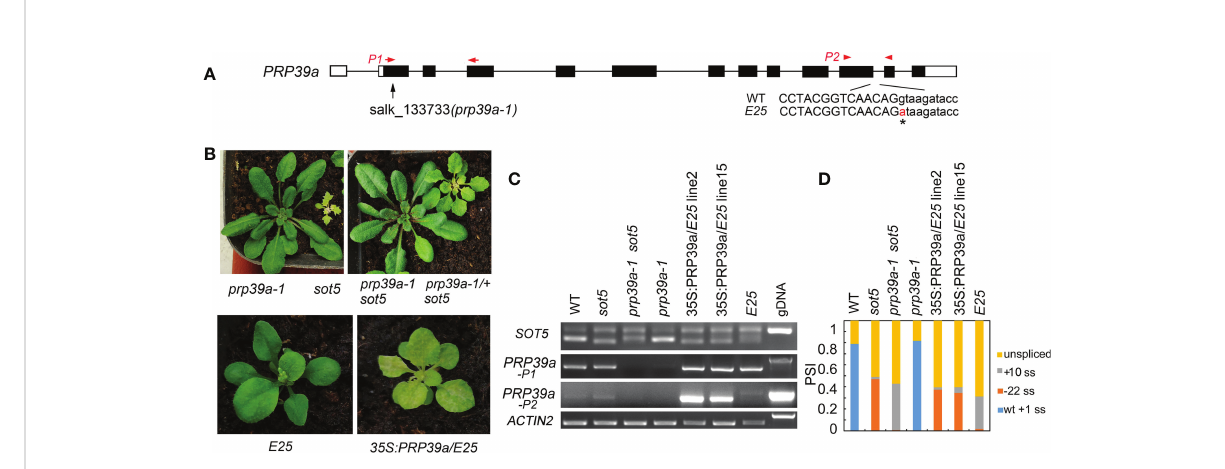
FIGURE 8 PRP39a is a new suppressor gene isolated from E25. (A) The schematic presentation of the PRP39a gene. The black boxes indicate exons and the black lines indicate introns. Black arrow showed the site of T-DNA insertion. The G to A point mutation of E25 was indicated by *. And red arrow and arrowhead showed the primer pair P1 and P2 used for RT-PCR, respectively. (B) Upper panel, phenotypes of prp39a-1, sot5, sot5 prp39a-1 and PRP39a-1/ + sot5 . Lower panel, phenotypes of E25 and 35S:PRP39a-gDNA/E25 transgenic plants. (C) RT-PCR analysis of the